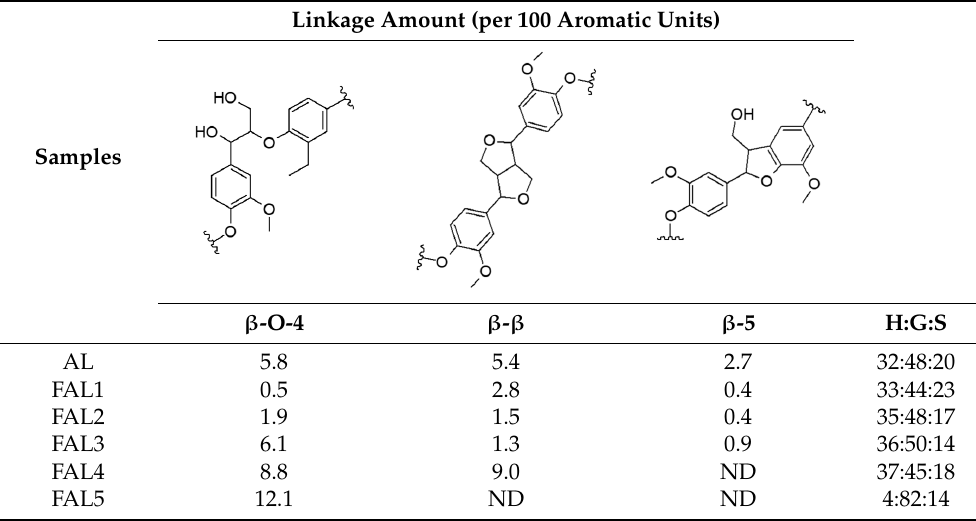
Table 4. Relative amounts of main interunit linkages in AL and its fractions.